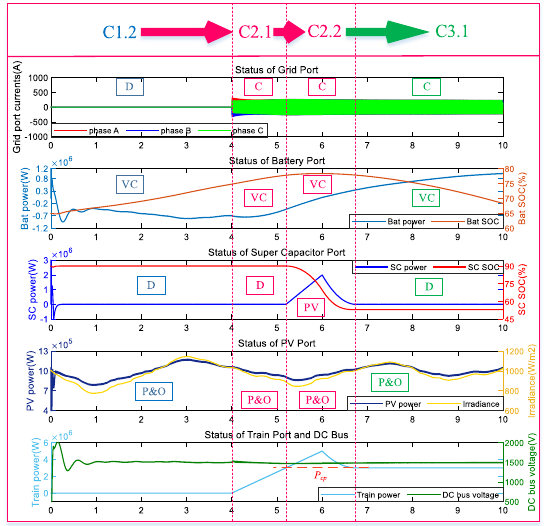
Fig. 13 Simulation waveform diagram of each port of the typical working condition switching under the acceleration state of the train